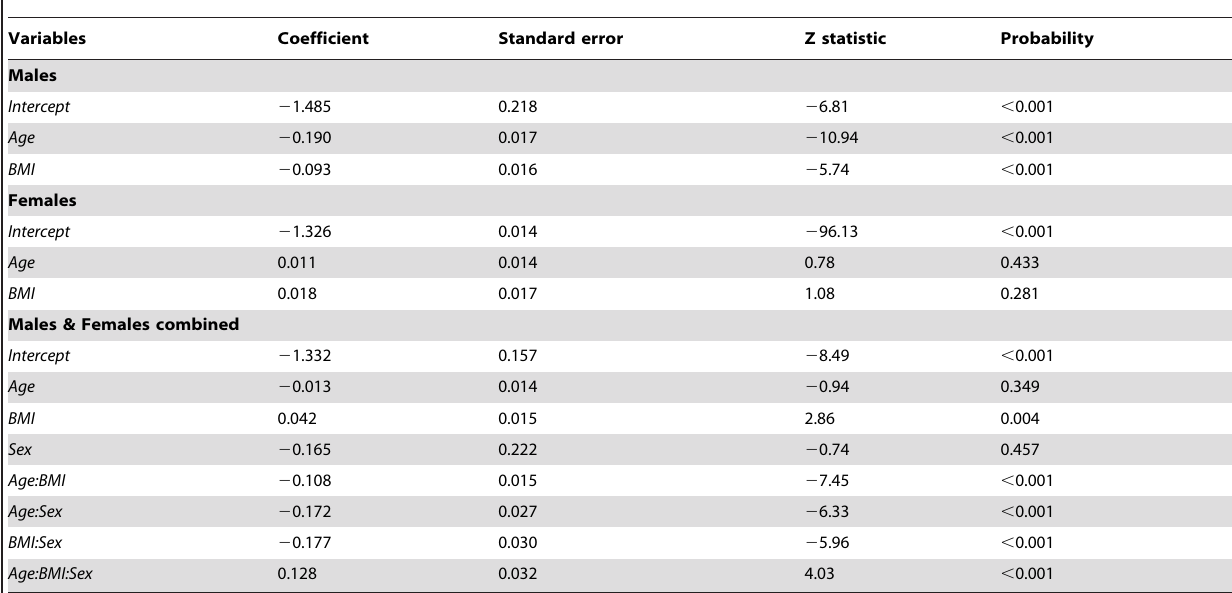
Table 4. Coefficients showing the influence of age, BMI and sex on the proportion of lymphocytes.